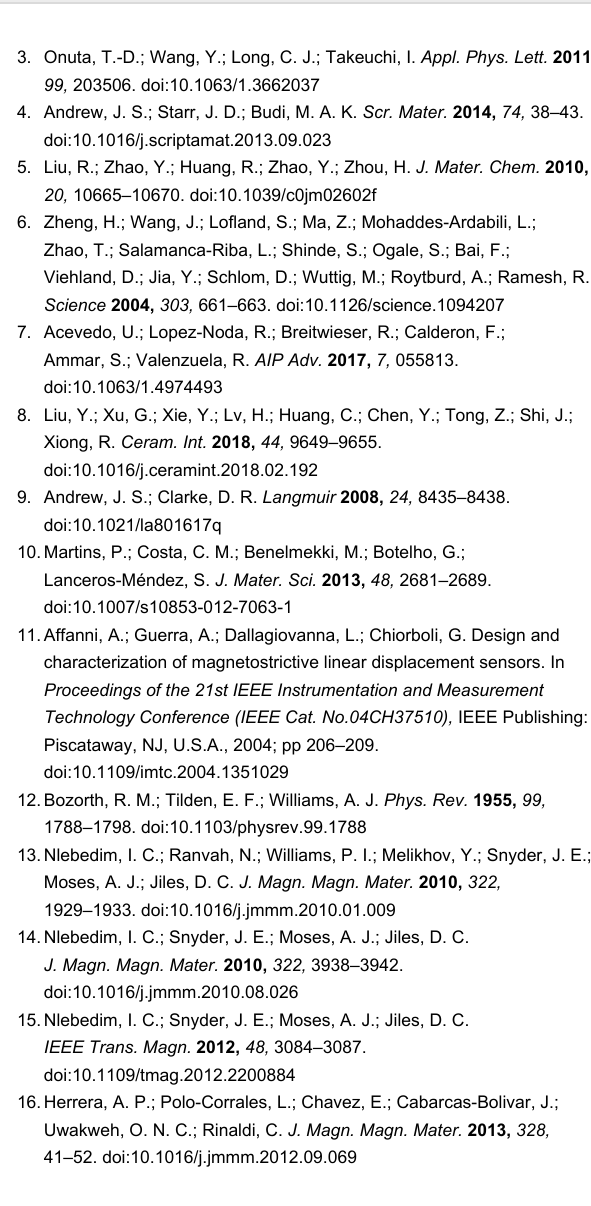
Figure 8: a) Representative scanning electron microscopy (SEM) image of the cobalt ferrite consolidated derivative and b) a schematic illustration of the custom-made magnetostriction measurement